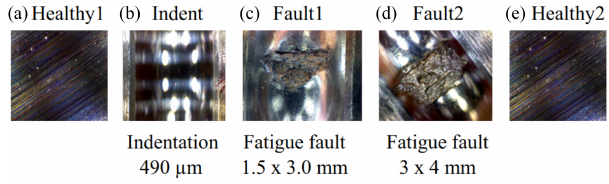
Figure 5. Five bearing states tested on the gearbox setup compris- ing two healthy bearings and three faulty bearings with different